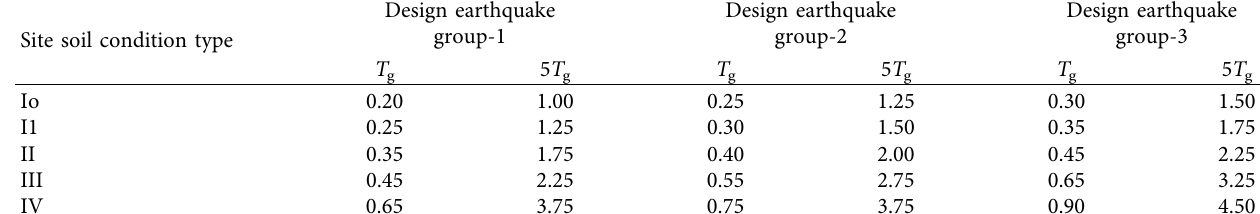
Table 10: GB11-10 corner period(s) for earthquake design group and soil type.